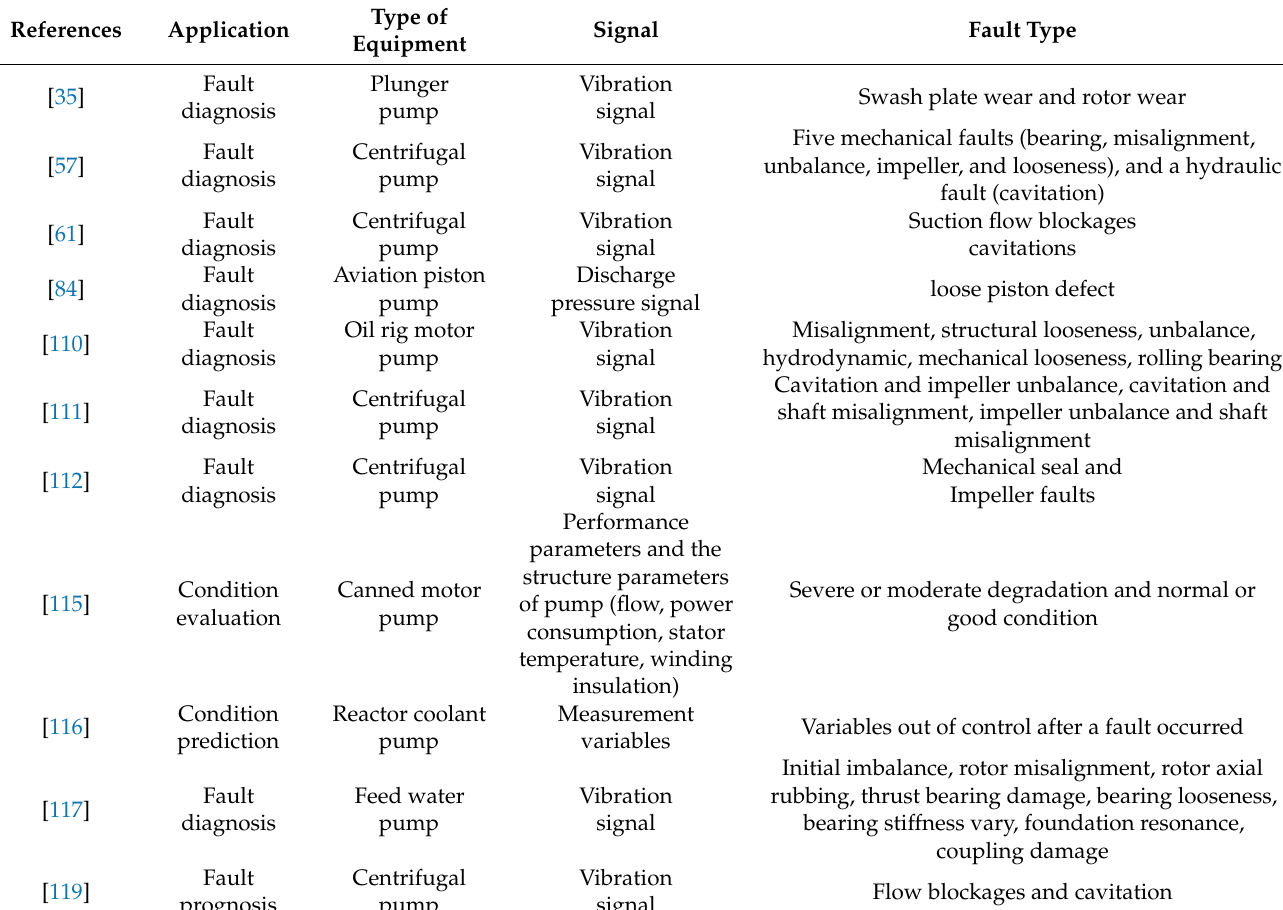
Table 14. Pump condition monitoring using support vector